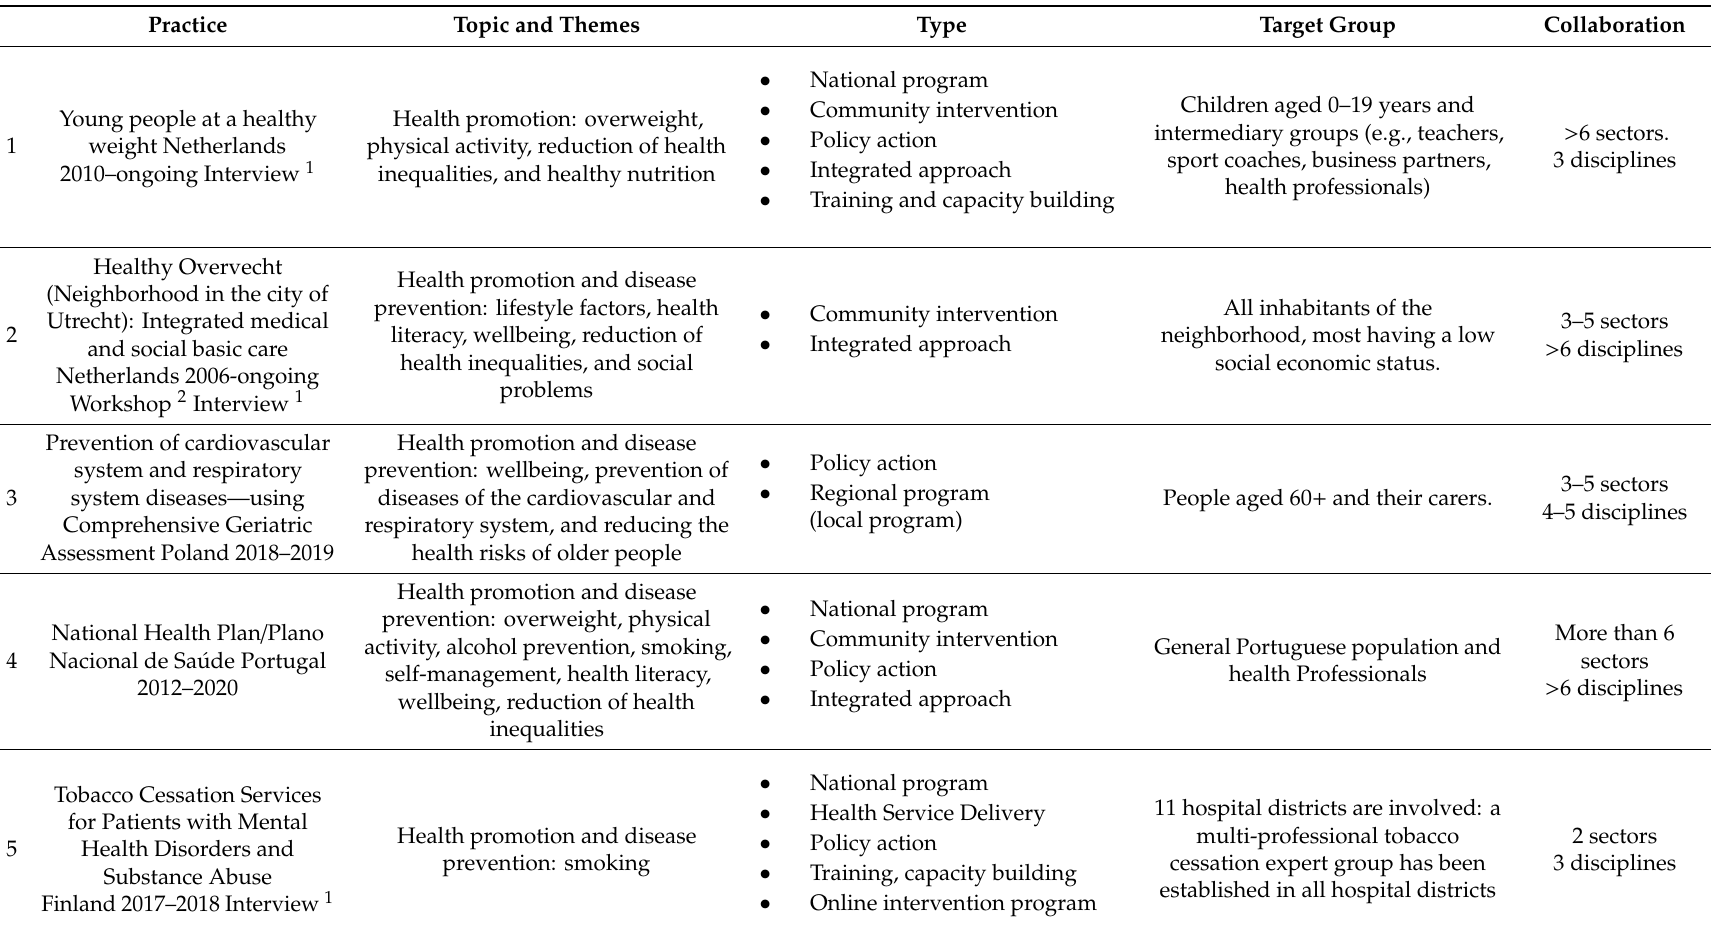
Table 1. Overview of good practices on health promotion (see also Table